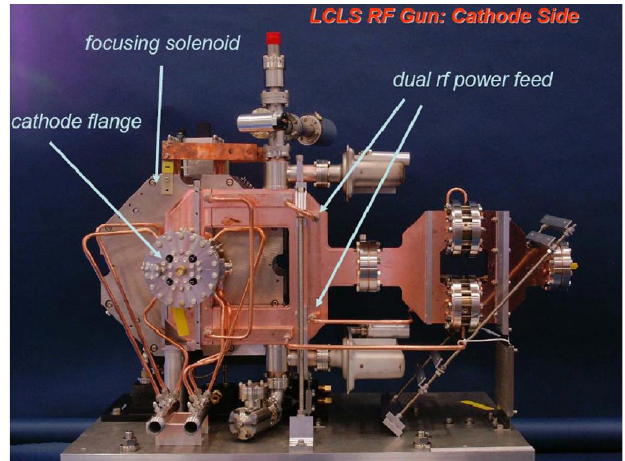
FIG. 6. (Color) The LCLS gun in cut-away view showing the full and half cells with the cathode flange at